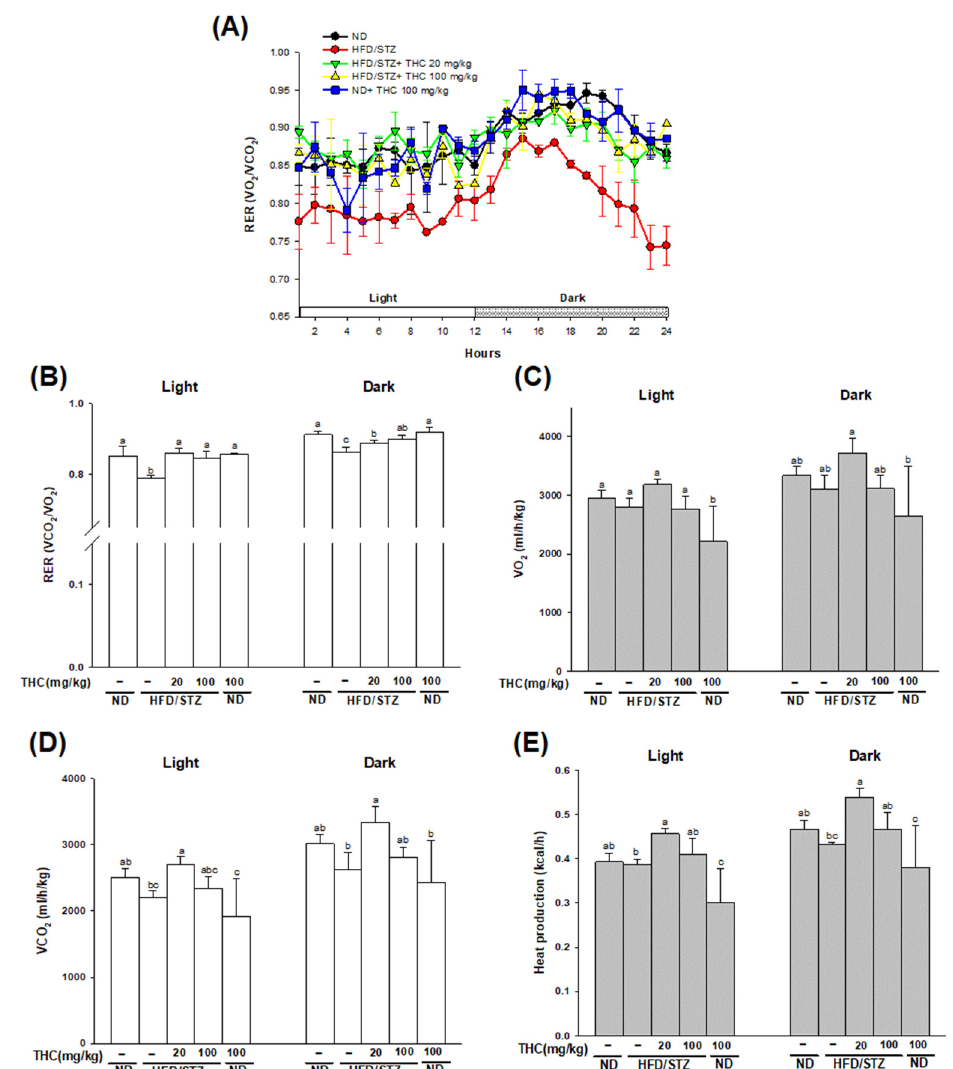
Figure 2. Effect of THC intervention on whole-body energy metabolism in HFD/STZ treated mice. Indirect calorimetry was performed on the TSE system. ( A ) Respiratory exchange ratios (RER = VCO 2 /VO 2 ) during a 24h period. ( B ) Average RER, ( C ) O 2 consumption, ( D ) CO 2 production and ( E ) heat production during the light and dark phase was calculated. Data are presented as mean ± SEM ( n = 4–5). Statistical differences ( p < 0.05) between groups were evaluated by one-way ANOVA with Tukey’s post-hoc test and were labeled as different letters (a, b, and c).